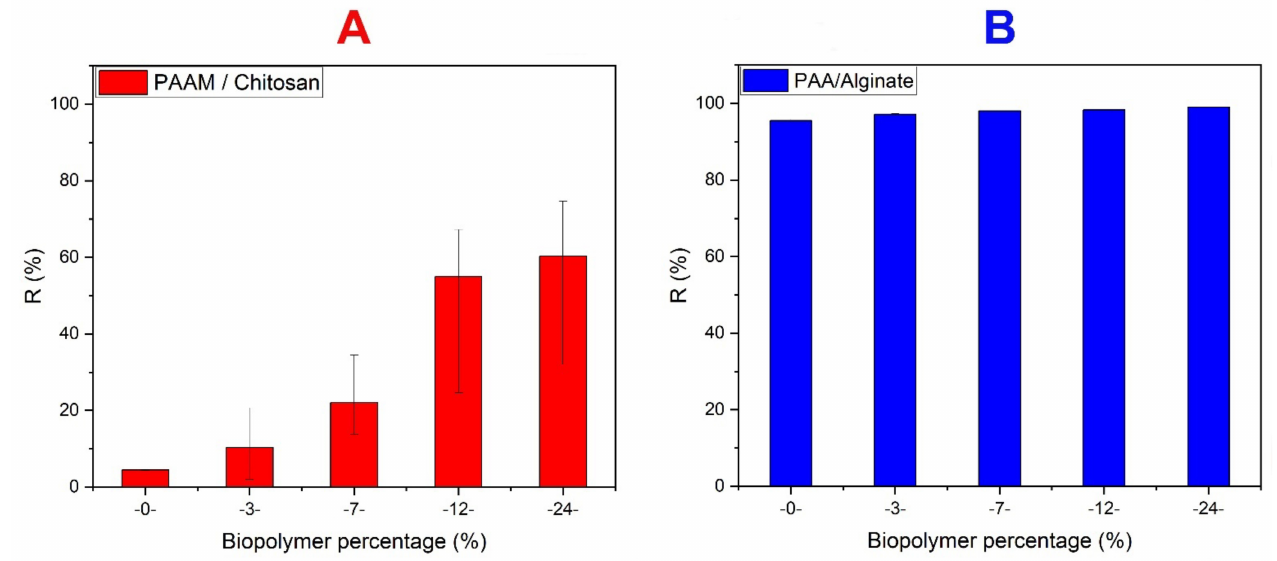
Figure 7. ( A ) Study of the chitosan percentage effect on PAAM/chitosan xerogels adsorbing MO (10 mg/L) at pH 3; ( B ) study of the alginate percentage effect on PAA/alginate xerogels adsorbing MB (10 mg/L) at pH